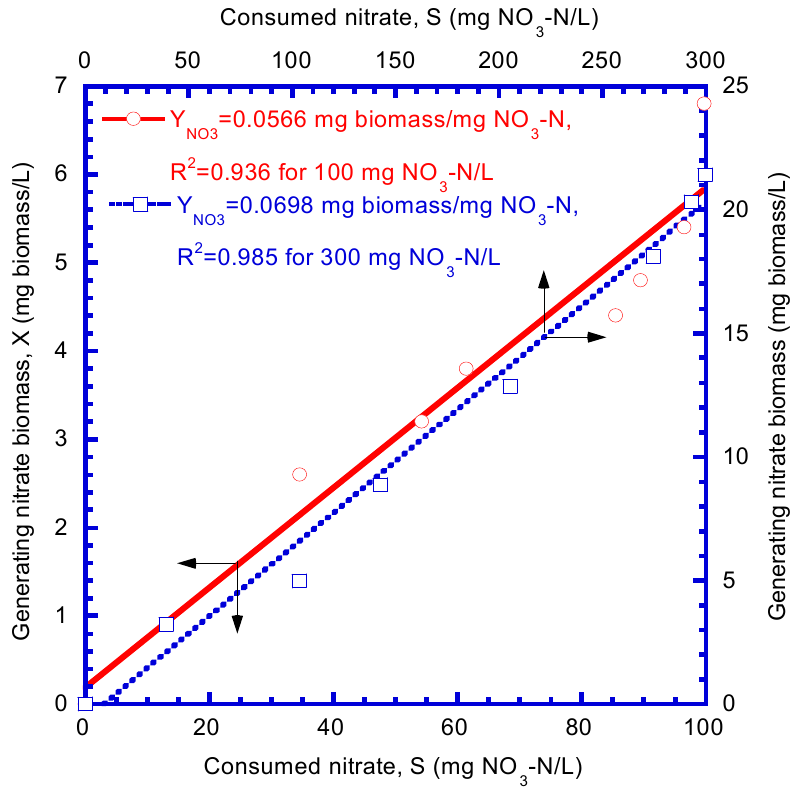
Figure 5. Batch kinetic test to determine nitrate biomass yield at different initial nitrate concentrations of 100 mg and 300 mg NO 3 -N/L.